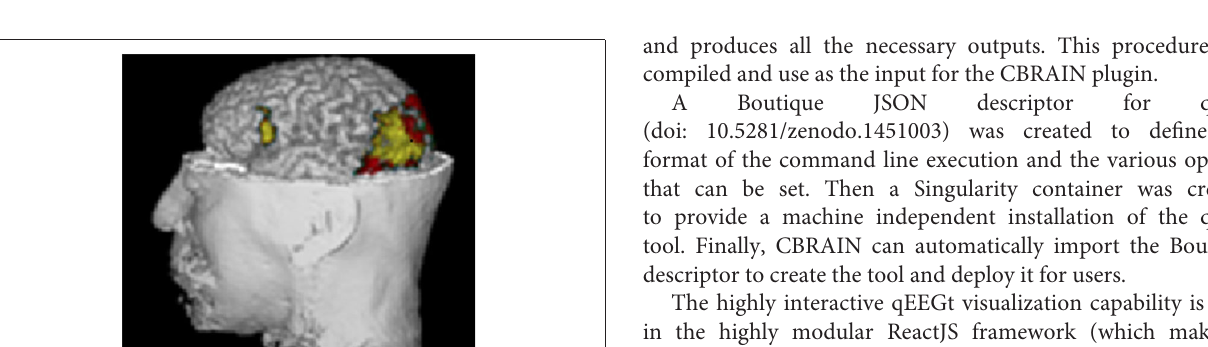
FIGURE 4 | Summary of the qEEGt analysis of the 71 years old patient. The more significant results are shown for bands Delta, Theta, and Gamma at two thresholds ( p = 0.05 and p = 0.01). (A) ( p = 0.05) and (B) ( p = 0.01) show a pathological excess of Delta activity in the right hemisphere. (C) ( p = 0.05) and (D) ( p = 0.01) show the excess of pathological activity in the right hemisphere and frontal part of the left hemisphere. (D) Shows that the most pathological areas in Theta coincide with the exact location of the surrounding area of the lesion. (E) Shows that no pathological activity was significant at 5.85 Hz for p = 0.01. (F) Shows a pathological decrease of activity in the Beta band, related to the location of the lesion and the edema area. No significant differences were found in the Alpha band. The implications of these results are discussed in the text.